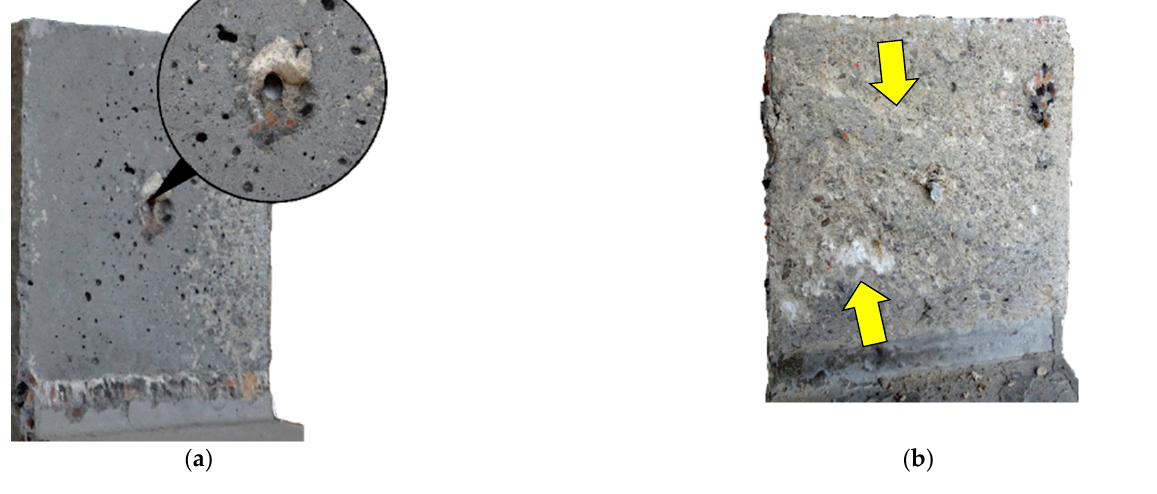
Figure 16. View of the test specimens with interface reinforcement after failure: ( a ) L30/30-S-0.14, ( b ) L30/50-S-0.14.